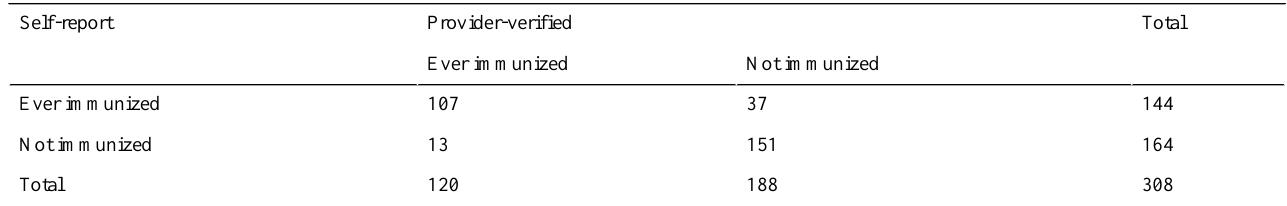
Table 3. Performance of self-reported immunization status for the HPV